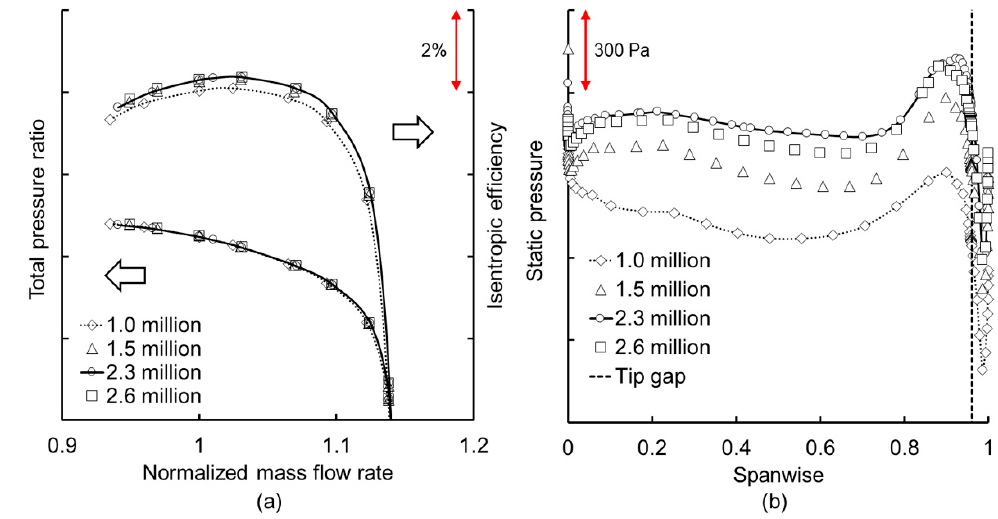
Figure 5. Grid independence: ( a ) performance at design speed and ( b ) spanwise distribution of static pressure at impeller exit, peak efficiency condition at design speed.